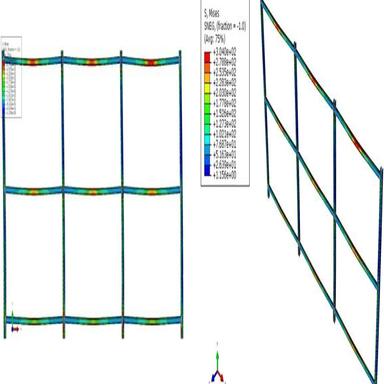
SR1: Von Mises stress-distribution at the middle surface at the peak load.